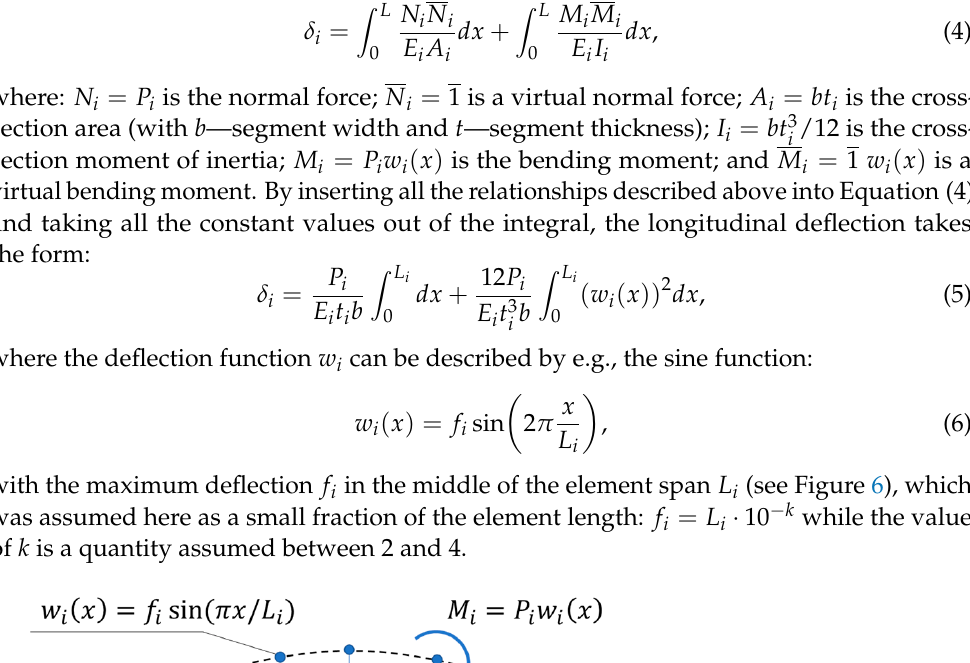
Figure 5. Compressed and stretched segments of a corrugated board cross-section during bending.